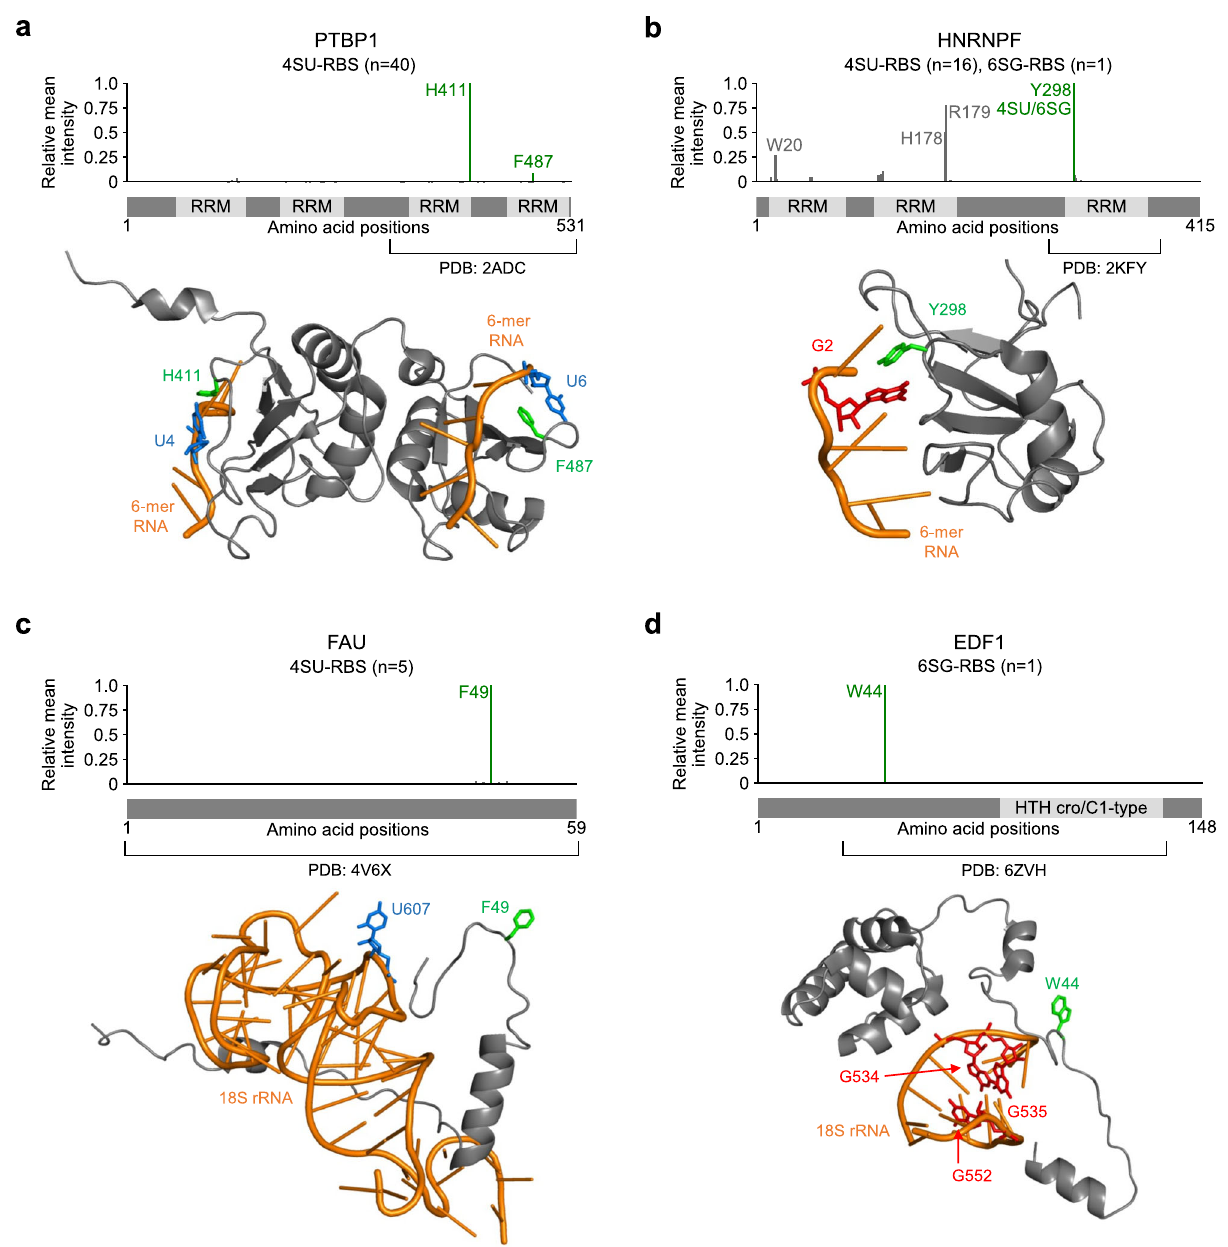
Fig. 4 Base-speci fi c RNA − protein interactions in RNP structures. a − d RBSs identi fi ed in this study (top) and their positions in known structures (bottom). One or two top-ranking RBSs from each protein are highlighted in green. The U and G residues proximal to RBSs are shown in blue and red, respectively. a Interaction between H411 or F487 in PTBP1 (4SU-RBSs) with proximal Us in structural data (PDB: 2ADC 30 ). b Interaction between Y298 in HNRNPF (both 4SU- and 6SG-RBS) with proximal G in structural data (PDB: 2KFY 31 ). c Potential interaction between F49 in FAU (4SU-RBS) and most proximal U in structural data (PDB: 4V6X 33 ). d Potential interaction between W44 in EDF1 (6SG-RBS) and proximal Gs in structural data (PDB: 6ZVH 34